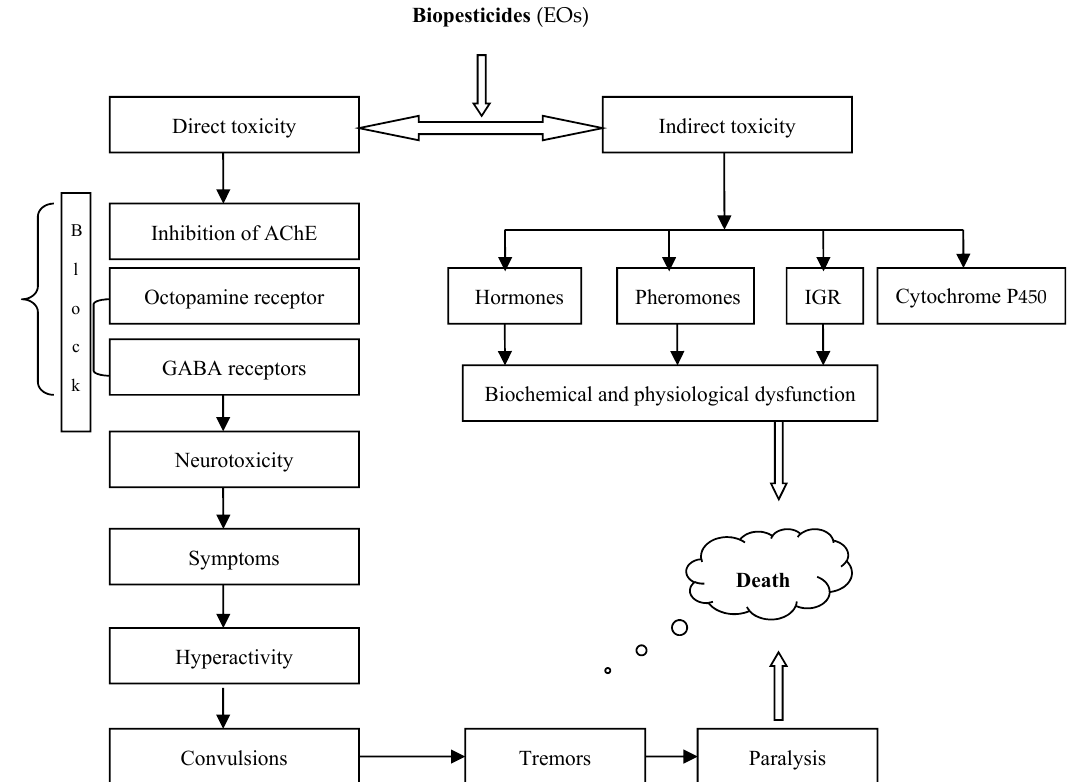
Figure 1. The action mechanism of essential oils on insects (adapted from Mossa 2016 [21]). ( notes :